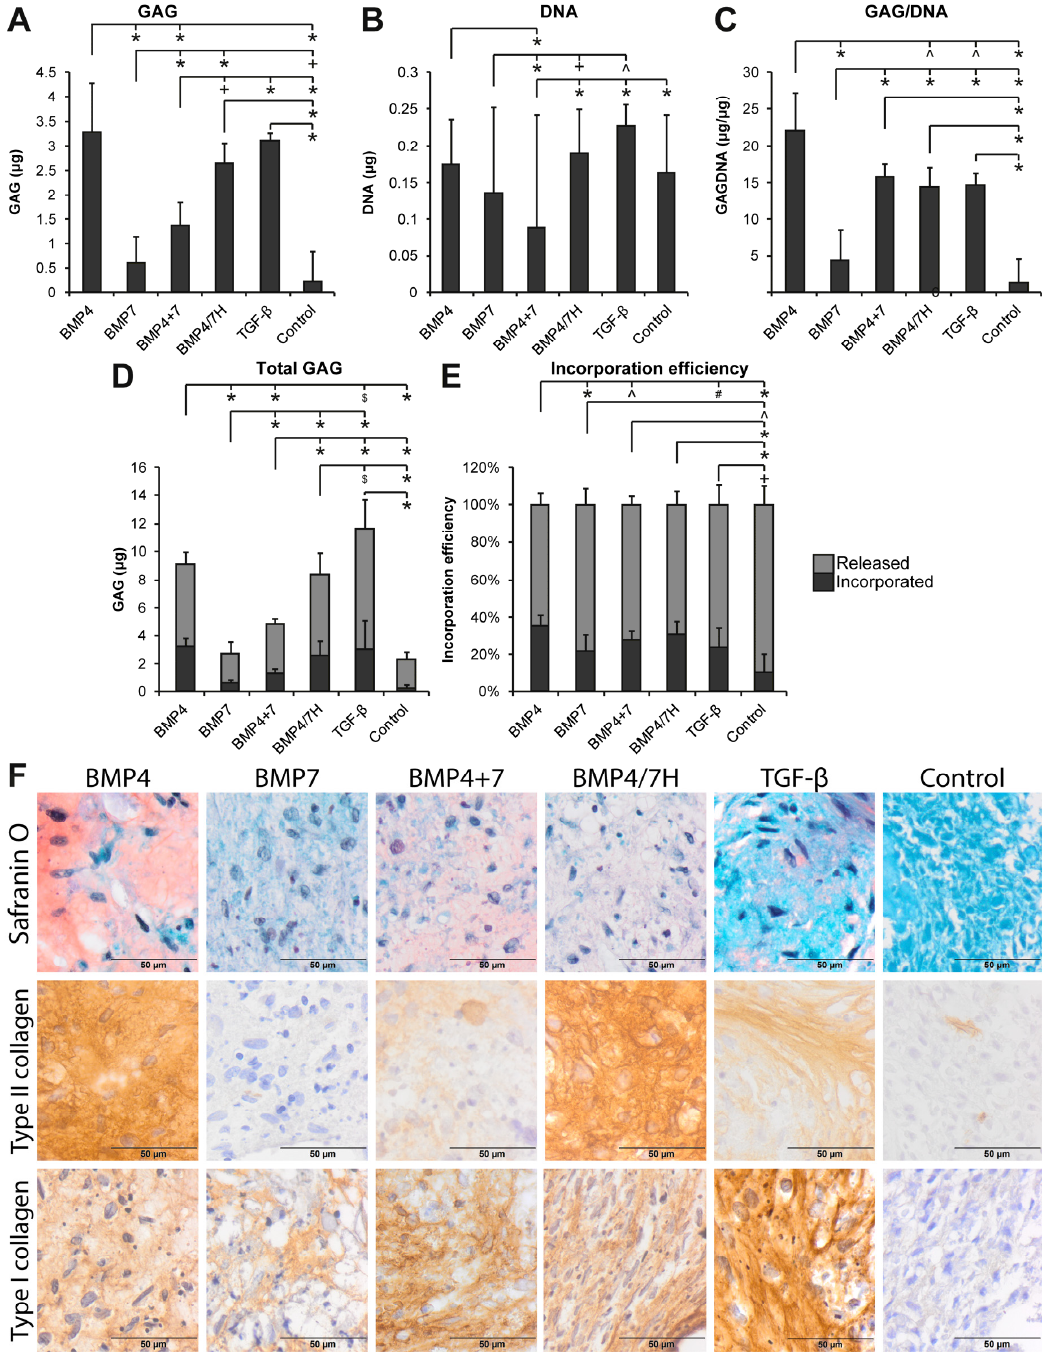
Figure 5. Matrix production and deposition of 50:50 nucleus pulposus: mesenchymal stromal cells (NP:MSC) pellet co-cultures in the presence of 0.4 nM bone morphogenetic proteins (BMPs), combination of homodimers, or heterodimer (H) were compared to 0.4 nM transforming growth factor (TGF- β 1) or the control (differentiation culture medium without BMPs or TGF- β 1). NP cells from 3 donors were co-cultured with MSCs from a single donor. All the data are n = 12 (4 separate repetitions per NP cell donor per condition). ( A ) Glycosaminoglycan (GAG) content was highest for BMP4, TGF- β 1, and BMP4/7H. ( B ) DNA content was higher for the pellets cultured with TGF- β 1 compared to BMP7 and BMP4+7. ( C ) GAG corrected for DNA was higher for all the growth factors